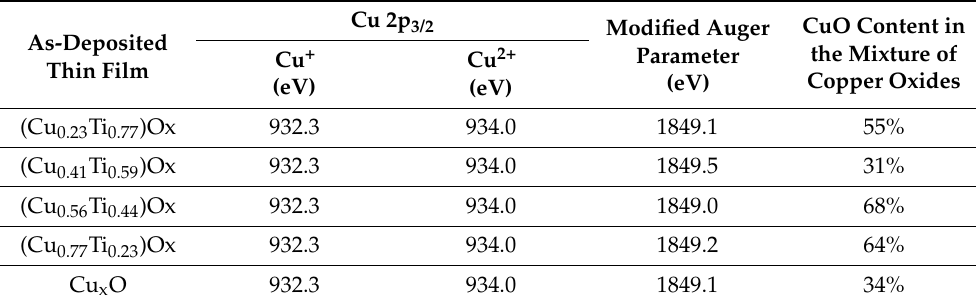
Table 1. Summary of Cu2p core level peak positions, modified Auger parameters, and CuO concen- tration of as-deposited thin